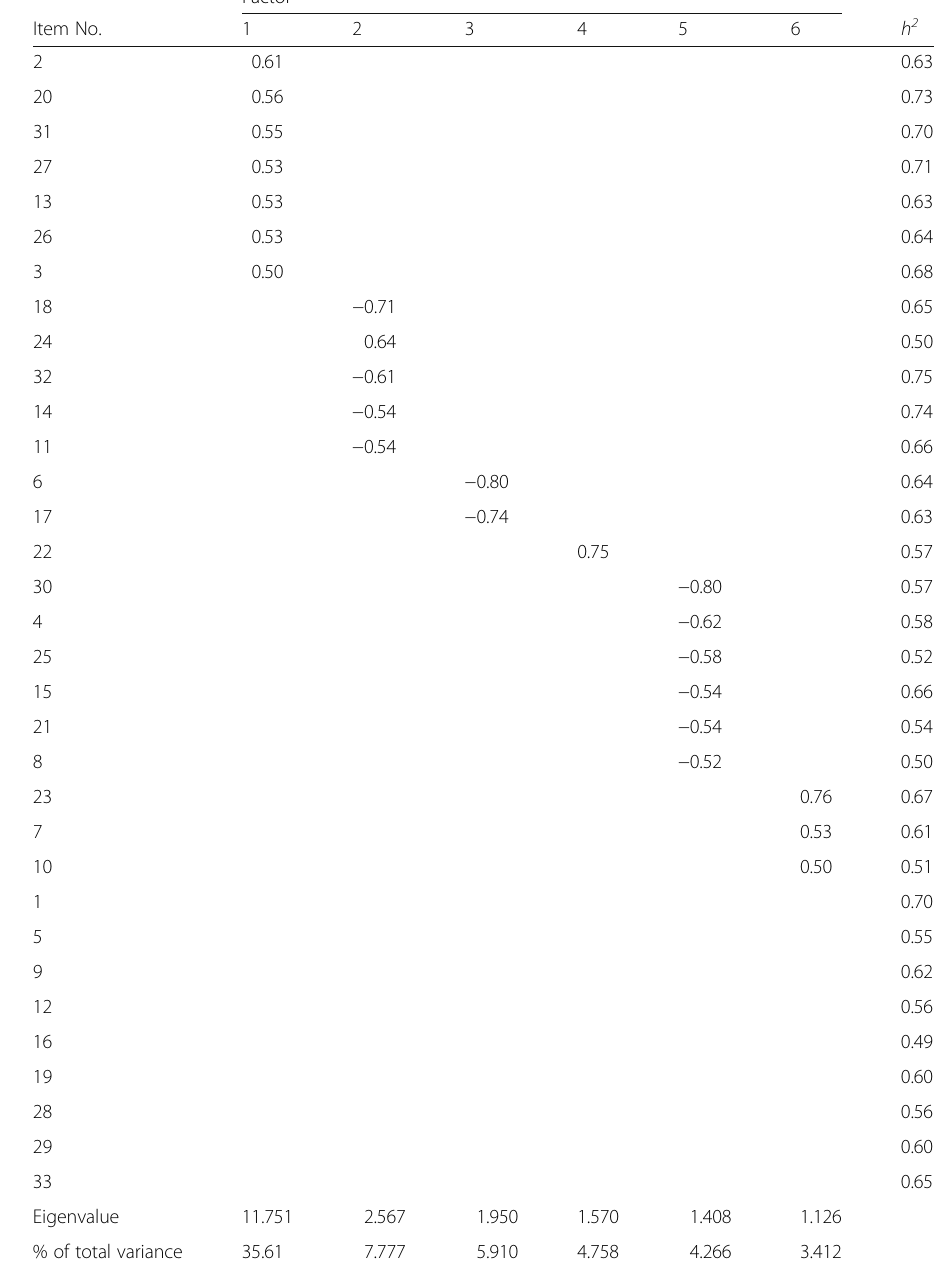
Table 3 Results of the first exploratory factor analysis of the FLCAS with direct oblimin rotation ( n = 149) Factor Item